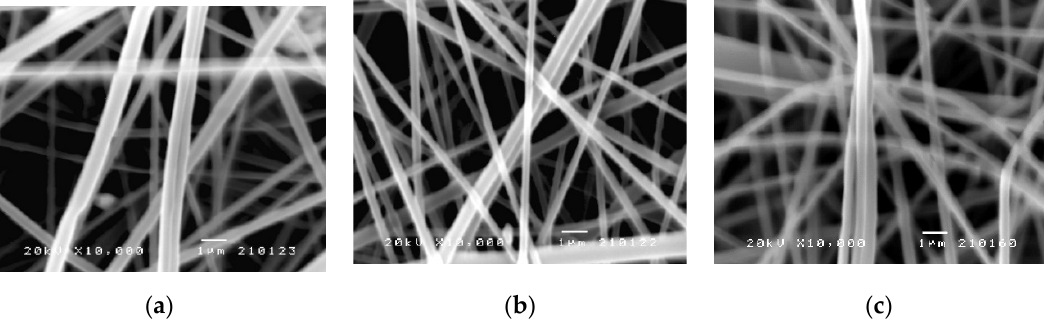
Figure 3. SEM images of electrospun fibers of: ( a ) PLA, ( b ) PLA-BCA-2%, and ( c ) PLA-BCA-5% (‘bar’ 1 μ m; magnification 10,000×).